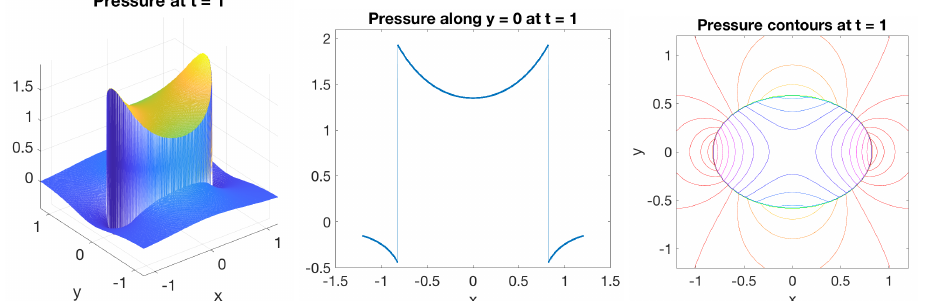
Figure 6. Numerical solution of the pressure in example 3 at time t = 1 for the blob ψ δ ( r ) in Table 1 using permeability parameter α = 0.01, regularization parameter δ = 0.06, N = 400, and µ = 1. The left panel shows the pressure in a region containing the membrane. The middle panel shows the pressure along the line y = 0. The right panel shows contours of the